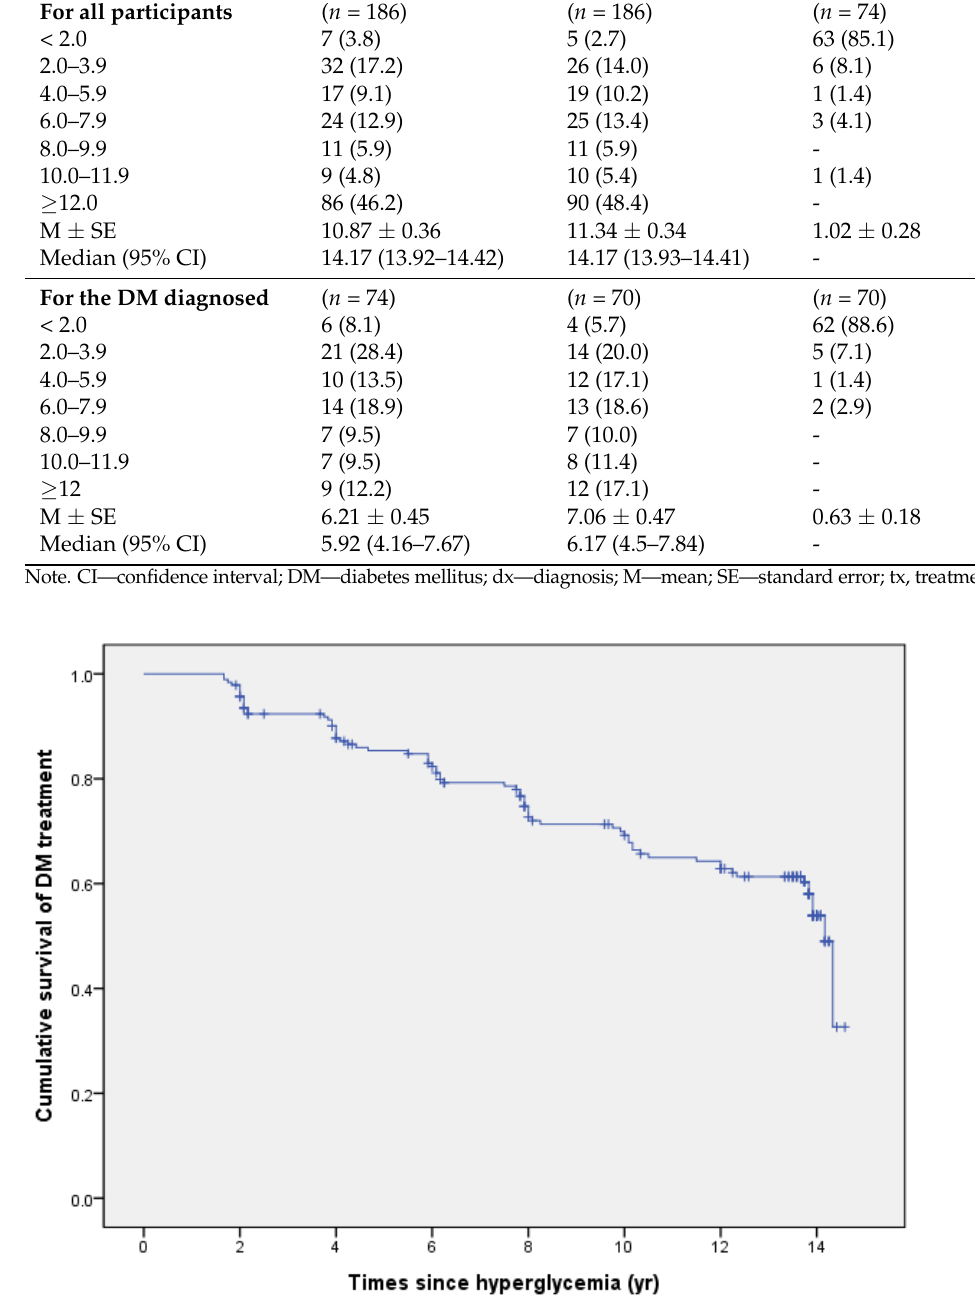
Figure 2. Kaplan–Meier curve for diabetes treatment over time for hyperglycemia. Table 3. Time to DM diagnosis and DM treatment according to participants’ characteristics at the 1st follow-up.